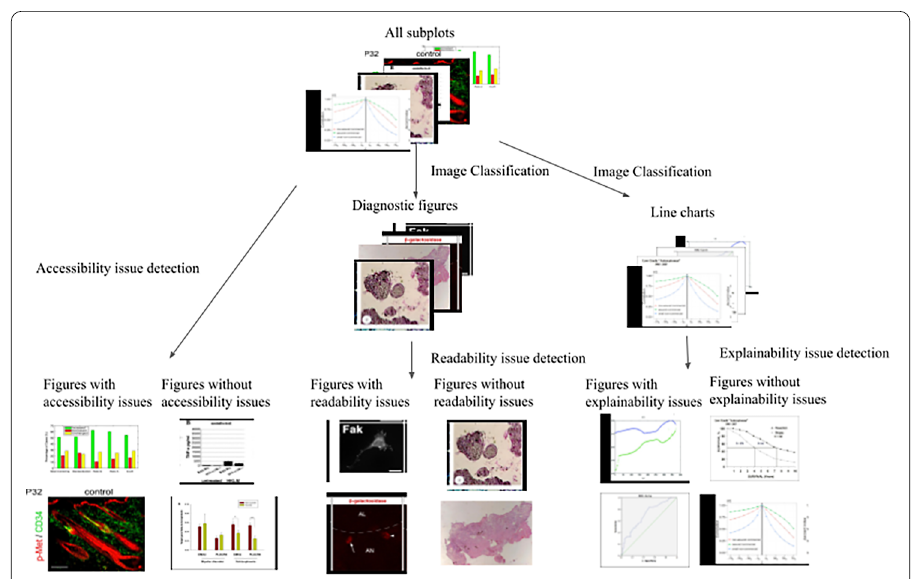
Figure 2 The illustration of results of our computational methods. After we obtain subplots from our image sample and separate subplots into different categories, our techniques detected examples above: color-blind unsafe figure, low light and contrast figures, and line charts with explainability issues